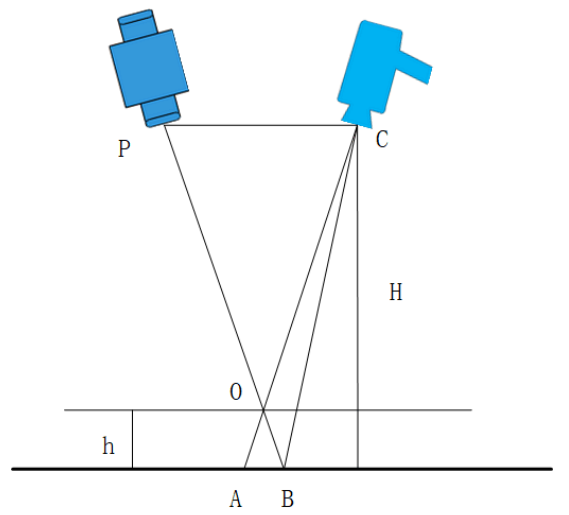
Figure 2. Optical principle of height position conversion.